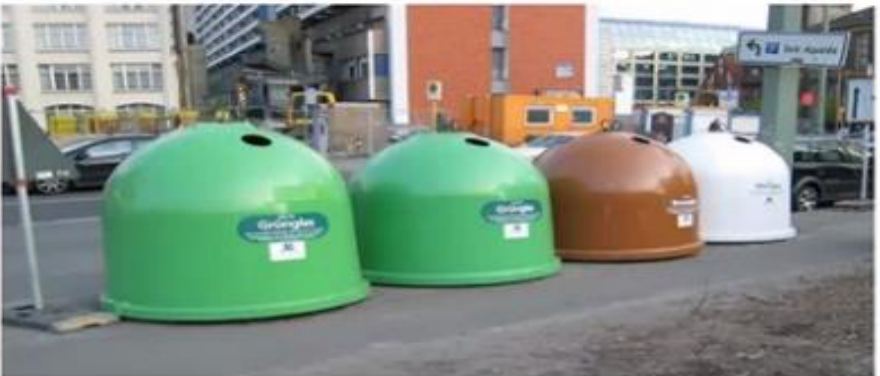
Figure 6. Colour-sorting public glass collection in Germany and throughout Europe. From the left, the first two bins are for green glass, the third is for brown- and darker-coloured glass and the white bin is for clear glass. Sorting by colour permits much higher recycled content in glass bottles [105].